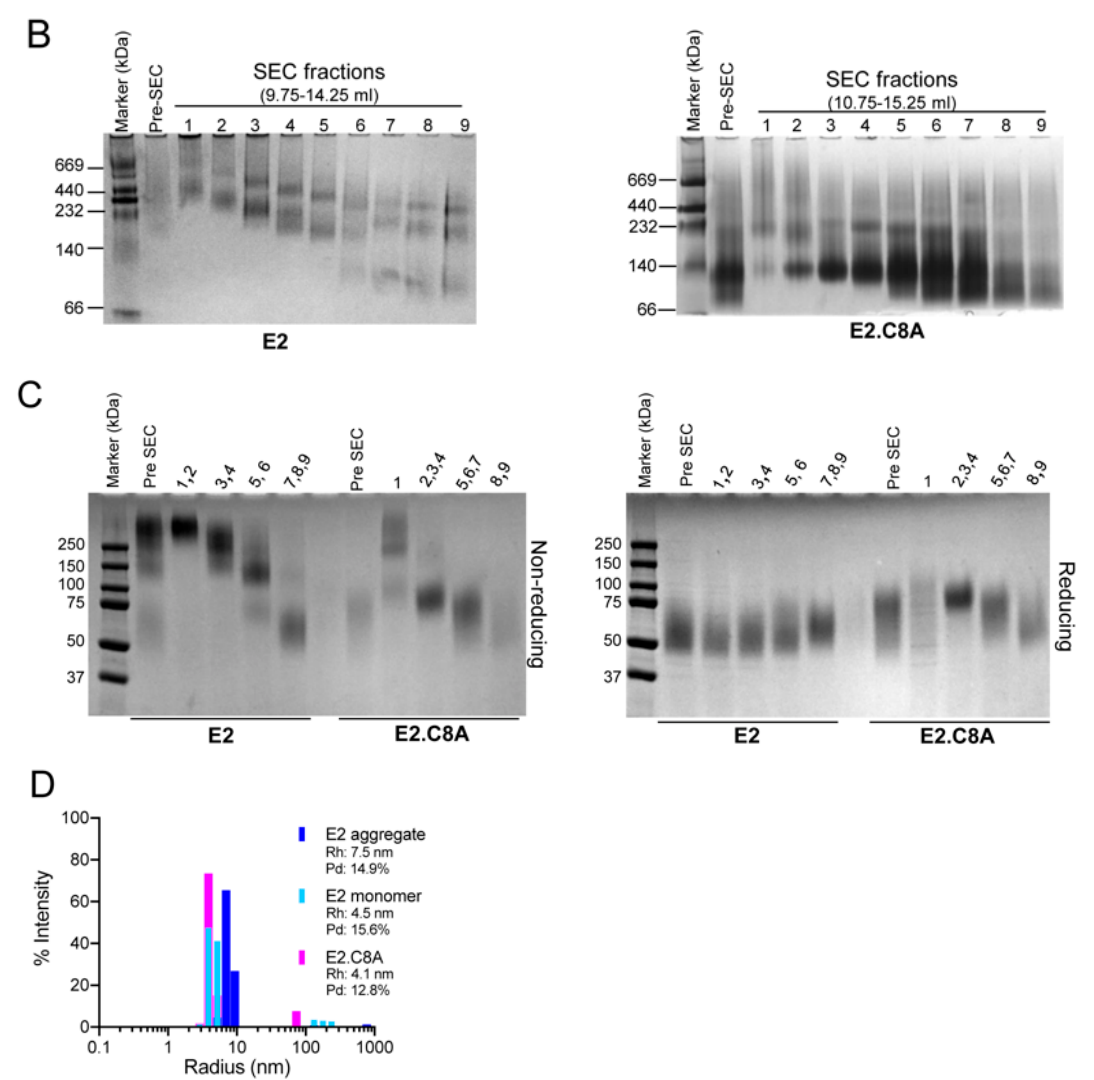
Figure 2. Characterization of purified E2 and E2.C8A. ( A ) Size-exclusion chromatography (SEC) profiles of StrepTactin-purified E2 and E2.C8A proteins. ( B ) BN-PAGE gels loaded with 5 µ g of proteins from each fraction followed by Coomassie blue staining of the SEC fractions obtained in A . Numbers indicate the fractions in 0.5 mL increments. Pre-SEC corresponds to the StrepTactin-purified protein sample before SEC. ( C ) Sodium Dodecyl Sulfate-Polyacrylamide Gel Electrophoresis (SDS-PAGE) analysis followed by Coomassie blue staining under non-reducing (left panel) and reducing (right panel) conditions of pooled fractions, corresponding to the same fractions as in Figure 2B. ( D ) Dynamic Light Scattering (DLS) profiles of E2 aggregates (E2 fractions 1–2, see B left panel), E2 monomers (E2 fractions 7–9, see B left panel) and E2.C8A monomers (E2.C8A fractions 8–9, see B right panel). Rh: hydrodynamic radius; Pd: polydispersity.